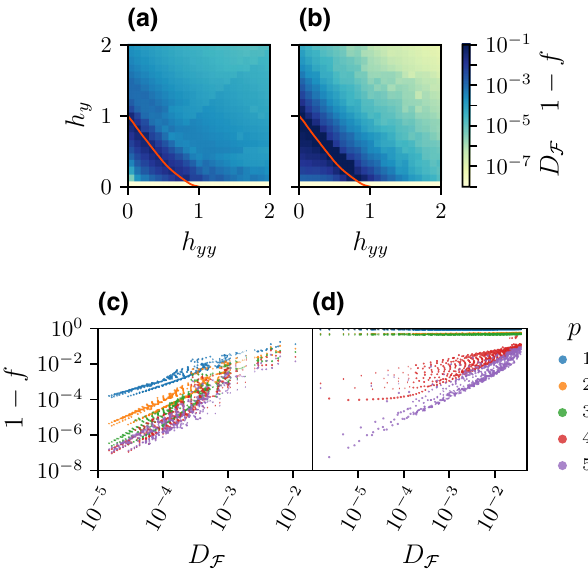
FIG. 7. Top row: interaction distance for the cluster Ising model in Eq. (B1) as a function of h yy and h y (a) and the infidelity 1 − f of the QAOA protocol (b). All data are for system size N = 8 with periodic boundary conditions. The red line is repro- duced from Ref. [71]. Bottom row: scatter plot of D F against 1 − f for the cluster Ising model, system size N = 8, and differ- ent values of p indicated in the legend. Panel (c) shows points above the critical line while (d) shows points below